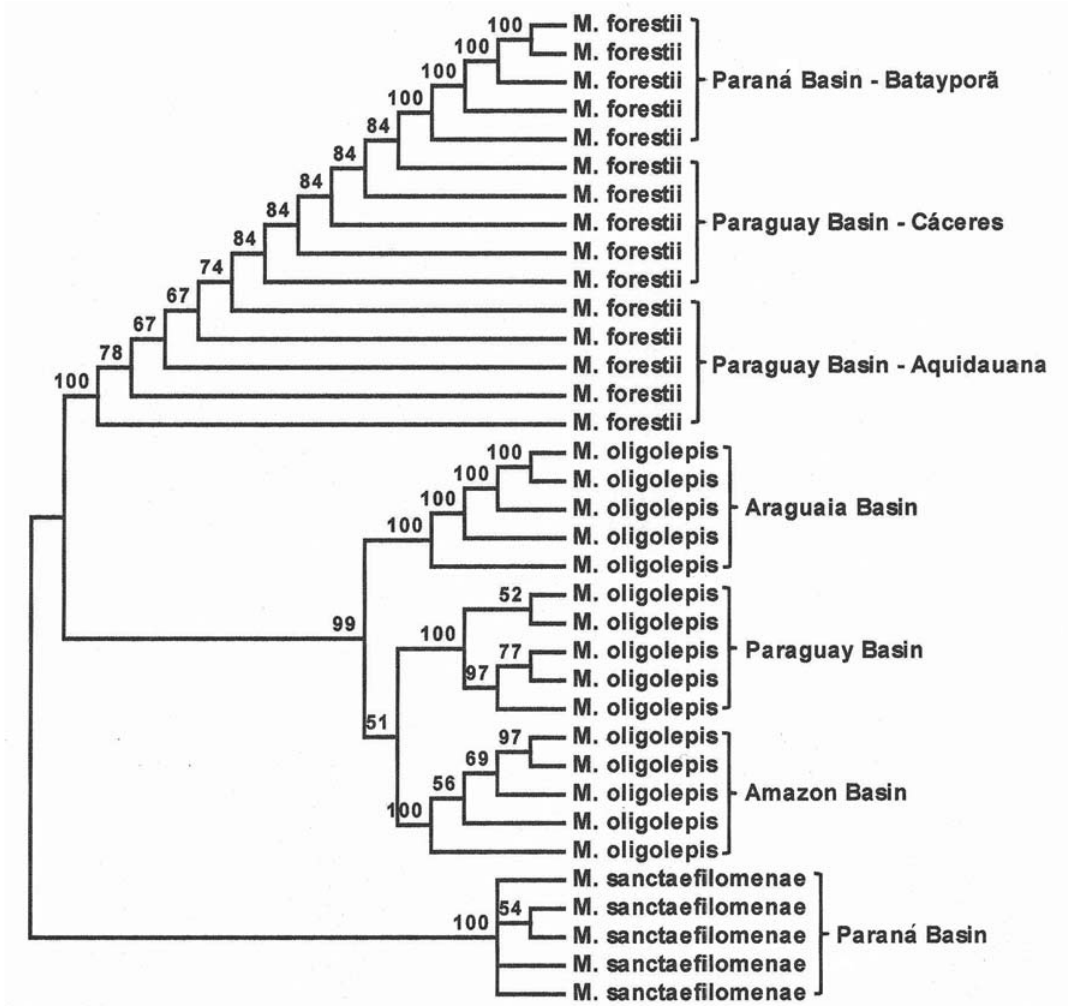
Fig. 4. Maximum Parsimony consensus tree for the mitochondrial gene Cytochrome Oxidase I. Numbers represent values of 1000 bootstrap